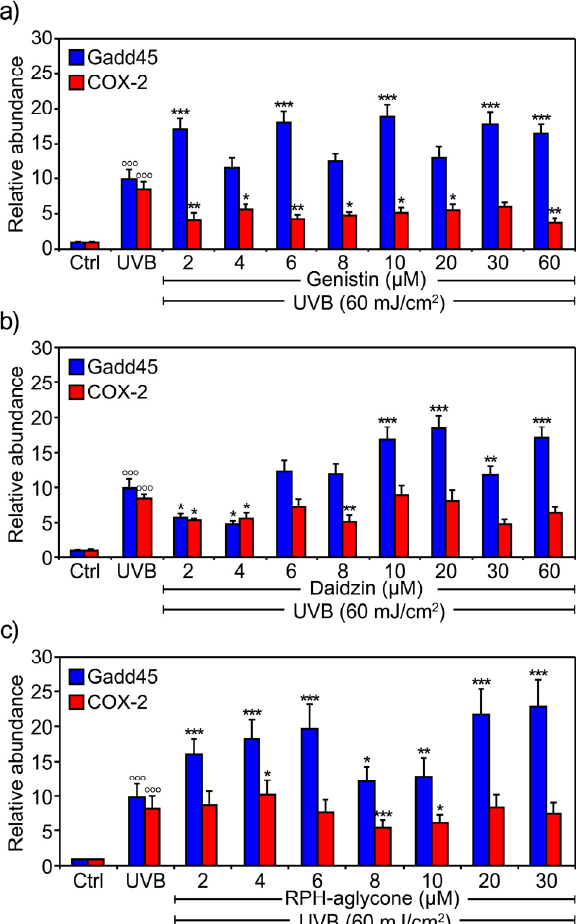
Figure 3. Effects of genistin, daidzin, and RPH-aglycone on the levels of Gadd45 and COX-2 mRNA in BJ-5ta cells irradiated with 60 mJ/cm 2 UVB. Levels of Gadd45 and COX-2 mRNA were determined by real-time PCR in BJ-5ta cells treated for 2 h with various concentrations of ( a ) genistin (from 2 µM to 60 µM); ( b ) daidzin (from 2 µM to 60 µM); or ( c ) RPH-aglycone (from 2 µM to 30 µM). Cells were harvested 24 h after 60 mJ/cm 2 of UVB irradiation. The bars indicate the relative abundance of each mRNA; +1 is the abundance of Gadd45 and COX-2 mRNA in unirradiated and untreated cells. All values represent the mean ± SD of triplicate experiments. * p < 0.05, ** p < 0.001, *** p < 0.0001, ◦◦◦ p < 0.0001 (Ctrl: untreated and unirradiated control cells; UVB: untreated and irradiated (60 mJ/cm 2 )